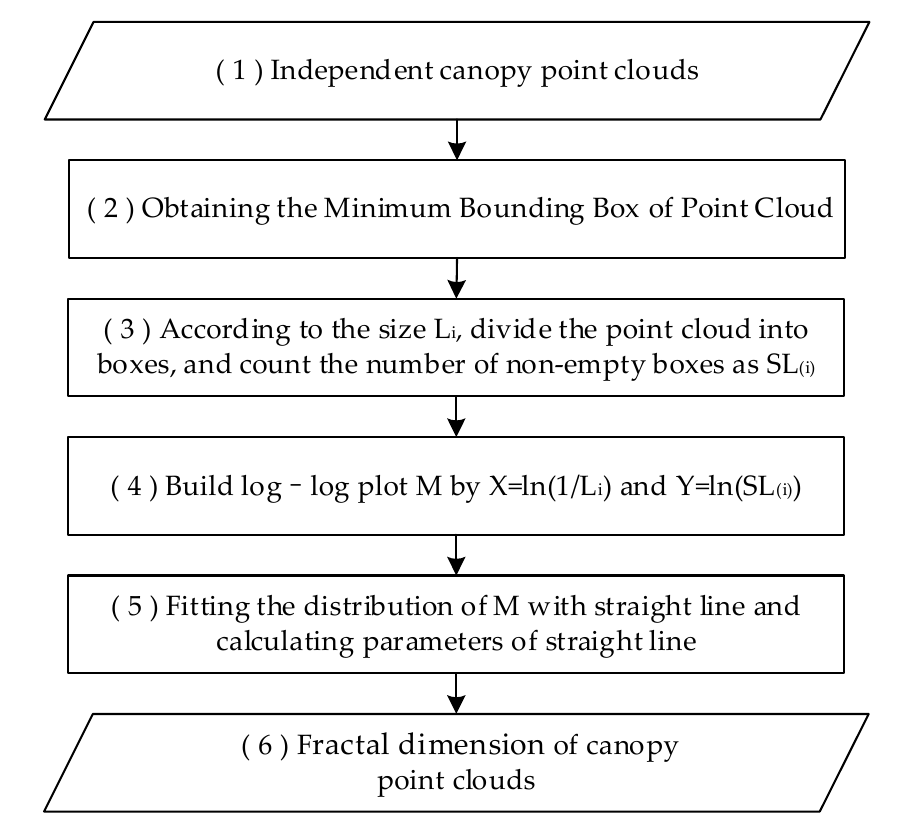
Figure 4. Flow chart of calculating the fractal dimension of point cloud data of an individual tree. First of all, parameters of the bounding box of an individual tree’s point cloud need 2.3. Box-Counting Dimension Fitting Based on RANSAC Gross Error Elimination to be obtained, and these parameters can help determine the spatial range of the point The point set of the double logarithmic scatter plots was obtained after completing cloud of an individual tree and the coordinates of the start point of the spatial box. dividing spatial box for times. Points in the point set were fitted with a straight line by using the least squares method, and the slope of the fitted line was the fractal di- 𝐼𝐼𝐼𝐼𝐼𝐼𝐼𝐼𝐼𝐼𝐼𝐼𝑙𝑙𝐼𝐼 mension. Considering that the slope of the fitted straight line was the fractal dimension of an individual tree, the dimension of an individual tree could not be infinite. became the coordinates of a point, 𝑀𝑀 𝑖𝑖 �𝑙𝑙𝑛𝑛 � 1 𝐿𝐿 𝑖𝑖 � , 𝑙𝑙𝑛𝑛 �𝑆𝑆 𝐿𝐿 𝑖𝑖 ( 𝐷𝐷 ) �� , in the point set of the double logarithmic scatter plots (log-log plot 𝑀𝑀 ). 𝑦𝑦 = 𝑘𝑘𝑘𝑘 + 𝑏𝑏 was used to obtain the equation of the fitted straight line. Random Sample Consensus algorithm (RANSAC) was first proposed by Fischler and Bolles [54] in 1981. This algorithm calculated parameters of a mathematical model accord- ing to a set of sample data, which contained abnormal data, and thus valid sample data would be extracted from the data set while abnormal sample data would be eliminated. RANSAC could help eliminate abnormal data from the point set of the log-log plot during the straight-line fitting process, and therefore more accurate and more robust fractal di- mension of the terrestrial point clouds of an individual tree would be obtained. When the RANSAC algorithm was used to eliminate abnormal data from the point set of the log-log plot, it is necessary to fully consider the characteristics of the point set to set proper number of iterations and other parameters. Characteristics of the point set of the log-log plot were as follows: 1. Data in the point set of the log-log plot only conform to linear models; 2. There is no same point in the point set of the log-log plot. Each point in the point set corresponded to a spatial partition, and side length of the box in each partition was dif- ferent (the side length would be monotonically increasing from initial side length as the iterative spatial partition proceeds). Accordingly, the abscissa of every point in the point set of the log-log plot was different, and parameters of the straight line could be fitted from any two points in the point set; 3. The spatial extent of the terrestrial point clouds of an individual tree was limited, so the number of points in the point set of the log-log plot would not be excessively large.